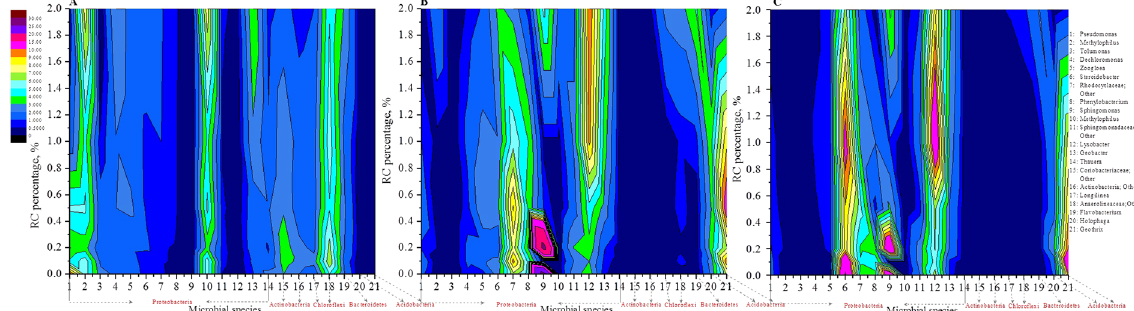
Figure 6. Microbe species (microbial relative abundance) responded with NP concentration and RC percentage. ( A ) NP concentration was 500 mg/Kg; ( B ) NP concentration was 50 mg/Kg; ( C ) NP concentration was 20 mg/Kg.